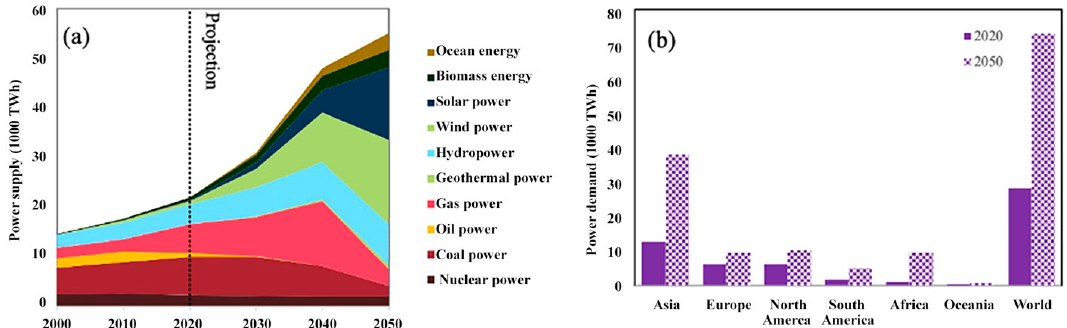
Figure 1. Global power supply and demand. ( a ) Global power generation from 2000–2050; ( b ) Comparison of power demand in different regions worldwide in 2020 and 2050. (Data source: The International Energy Agency during the period 2000–2017) [6]; the predicted data from 2020–2050 [7].